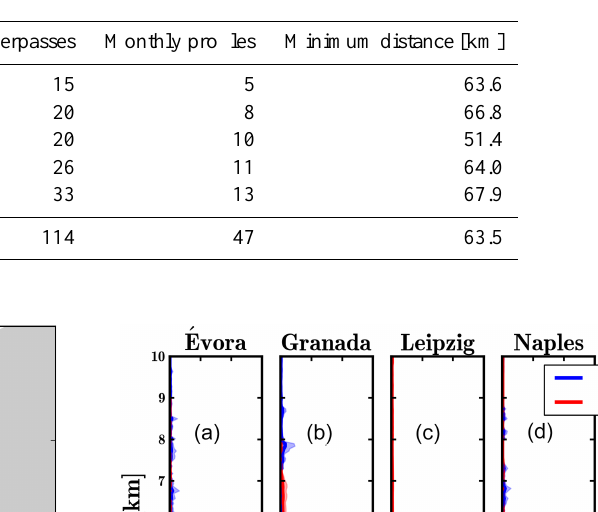
Table 3. Number of CALIPSO overflights and EARLINET correlative observations along with the produced monthly profiles, and the minimum distance between the satellite ground track and the EARLINET station.